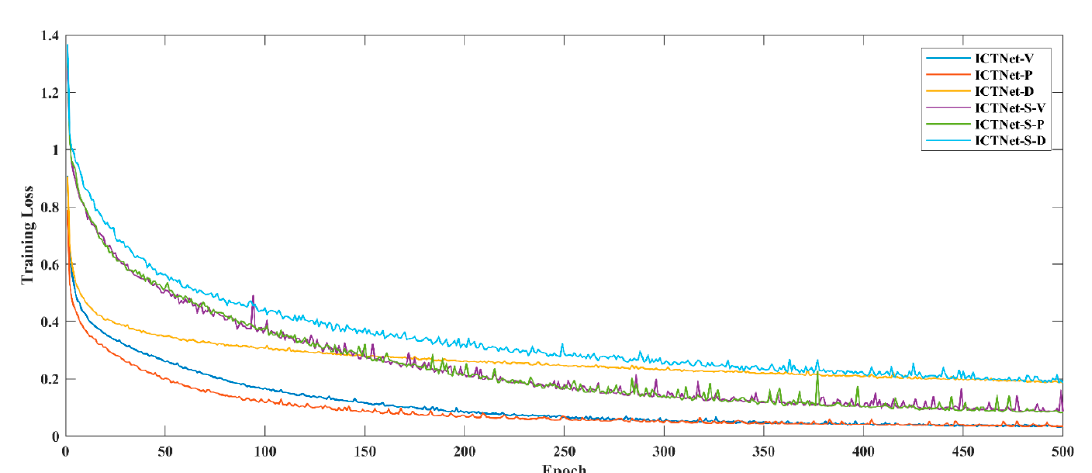
Remote Sens. 2022 , 14 , x FOR PEER REVIEW Figure A1. Training loss of ablation study of DFA. Figure A1. Training loss of ablation study of DFA.